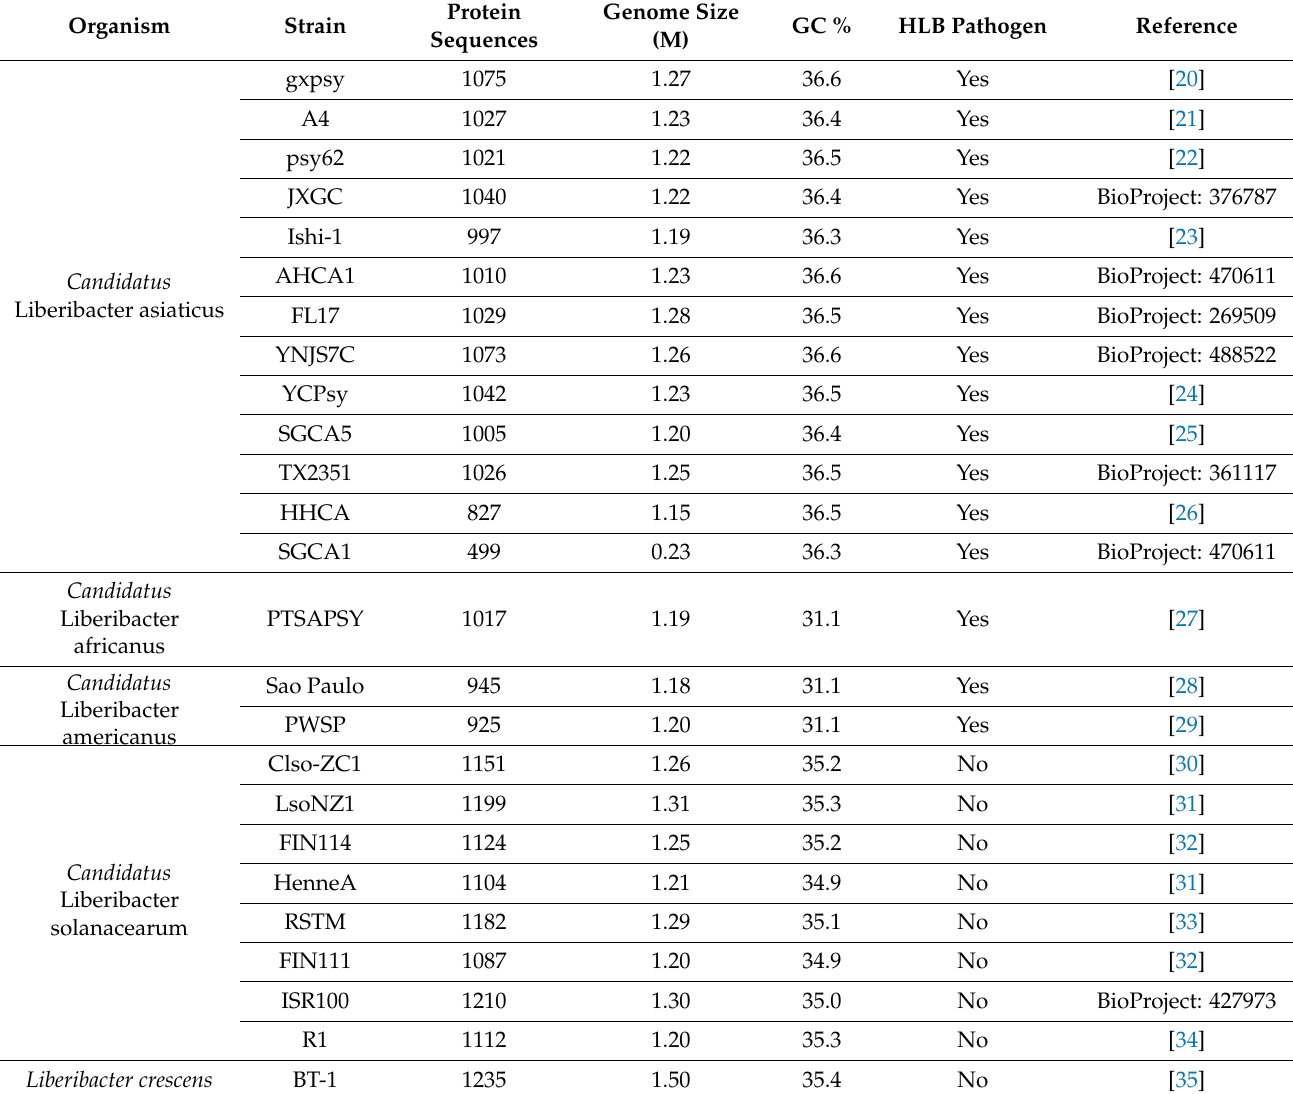
Table 1. List of the Liberibacter proteomes that are integrated into GreeningDB. Five species within Liberibacter genus are included: Ca . Liberibacter asiaticus, Ca . Liberibacter africanus, Ca . Liberibacter americanus, Ca . Liberibacter solanacearum, and L. crescens . Sources of unpublished proteomes are provided in the form of NCBI BioProject identifiers.